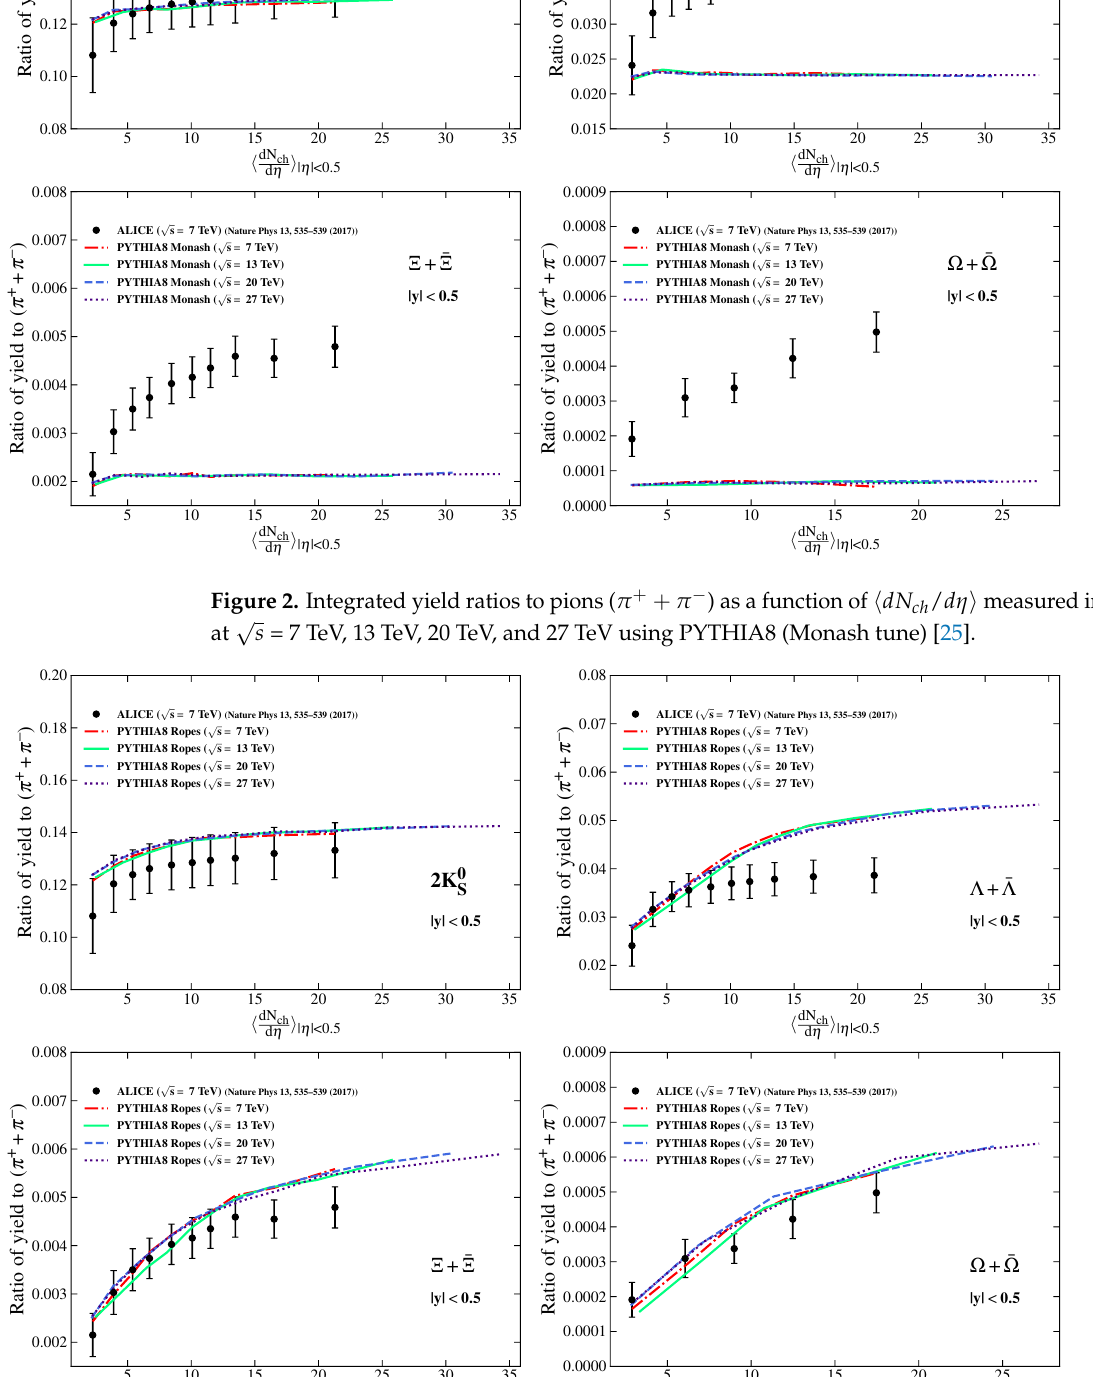
< 0.5 dN ch / d η y measured in (cid:104) (cid:105) | |